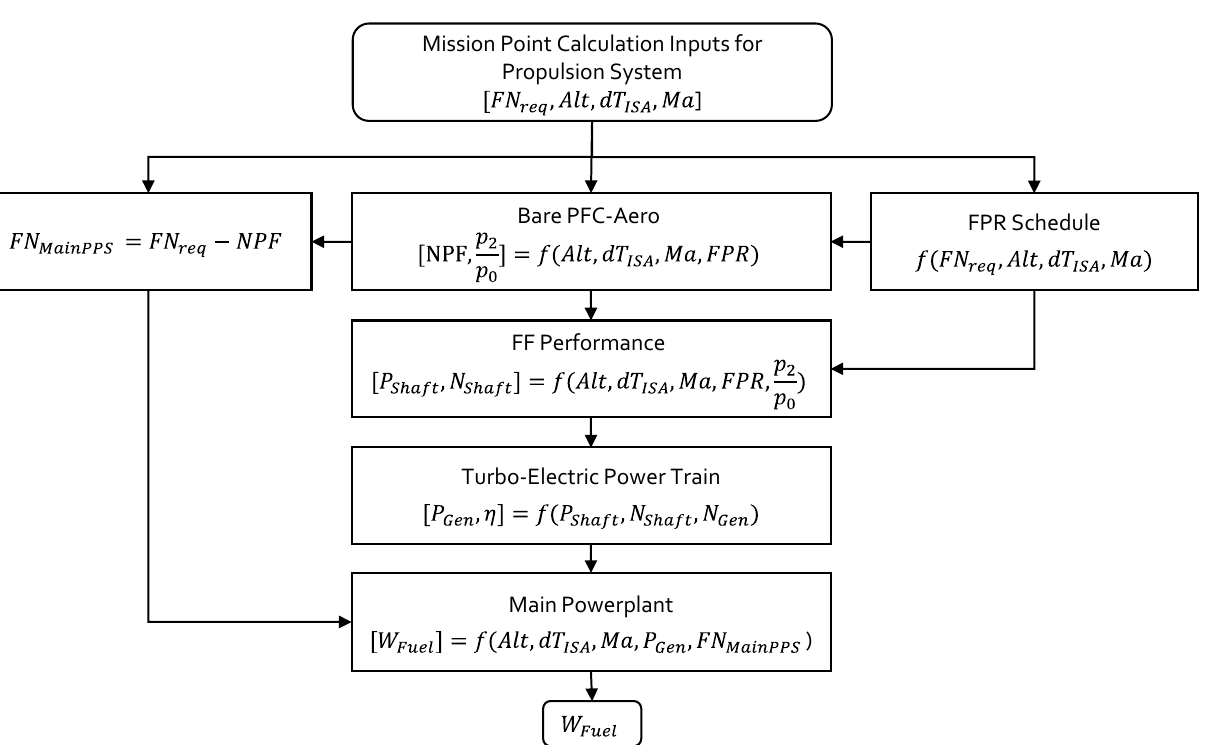
Figure 29. Logic for PFC point performance evaluation within aircraft sizing framework (adapted from [97]).